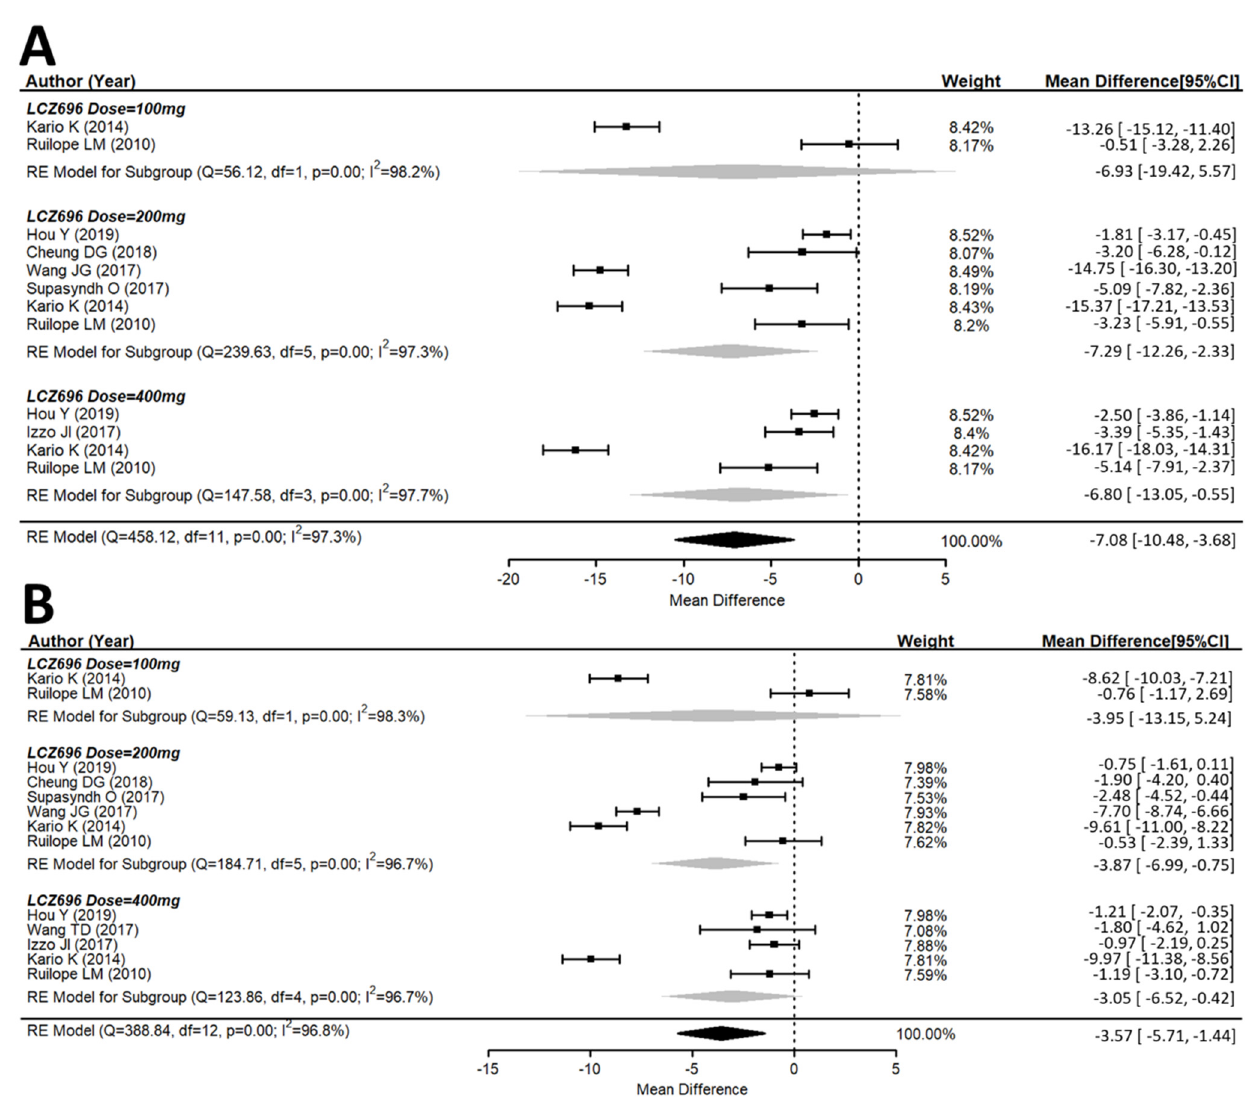
Figure 3. Forest plot of ( A ) maSBP and ( B ) maDBP. Comparisons of LCZ696 with a control group. maSBP, mean ambulatory systolic blood pressure; maDBP, mean ambulatory diastolic blood pressure.